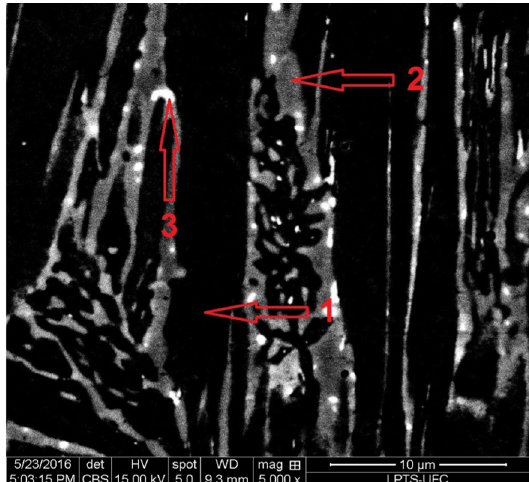
Figure 8. Microstructure of the zone fused with the AWS ER2209 electrode using energy of 8 kJ / cm with 100 hours of AHT. Highlighted phases (1) Table 5. Chemical composition by weight (%) of the austenite, sigma and chi phases in the FZ. Phases